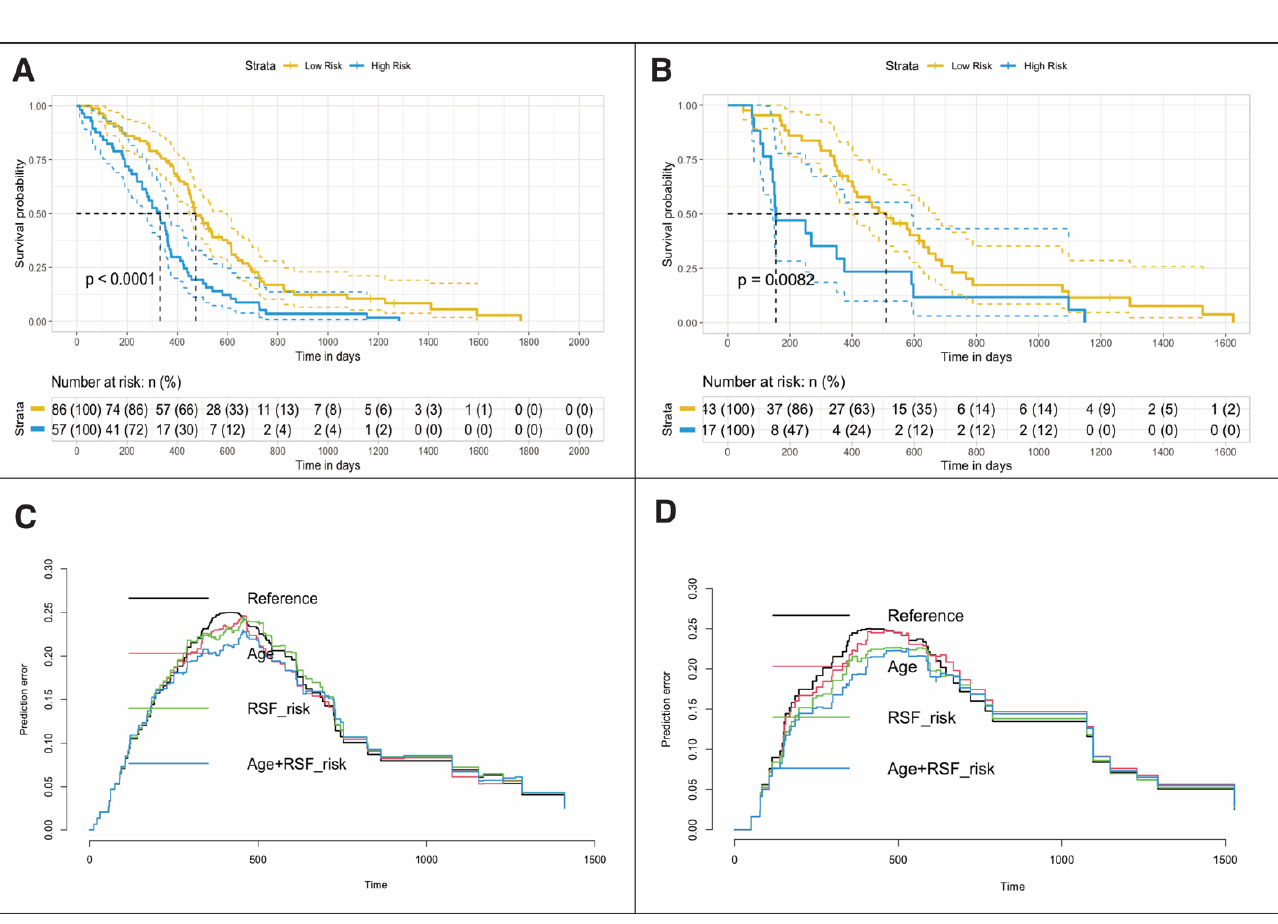
Figure 3. Kaplan – Meier plots showing differences in overall survival for patients in training ( A ) and testing ( B ) data sets stratified into low- or high-risk groups by random survival forest (RSF)-based ensemble mortality. Prediction error curves show Cox regression model performance in the training ( C ) and testing ( D ) groups. HR= Hazard Ratio, RSF = Random Survival Forest, IBS = Integrated Brier Score, iAUC = Integrated area under the curve, 6m – AUC = six months - area under the curve.